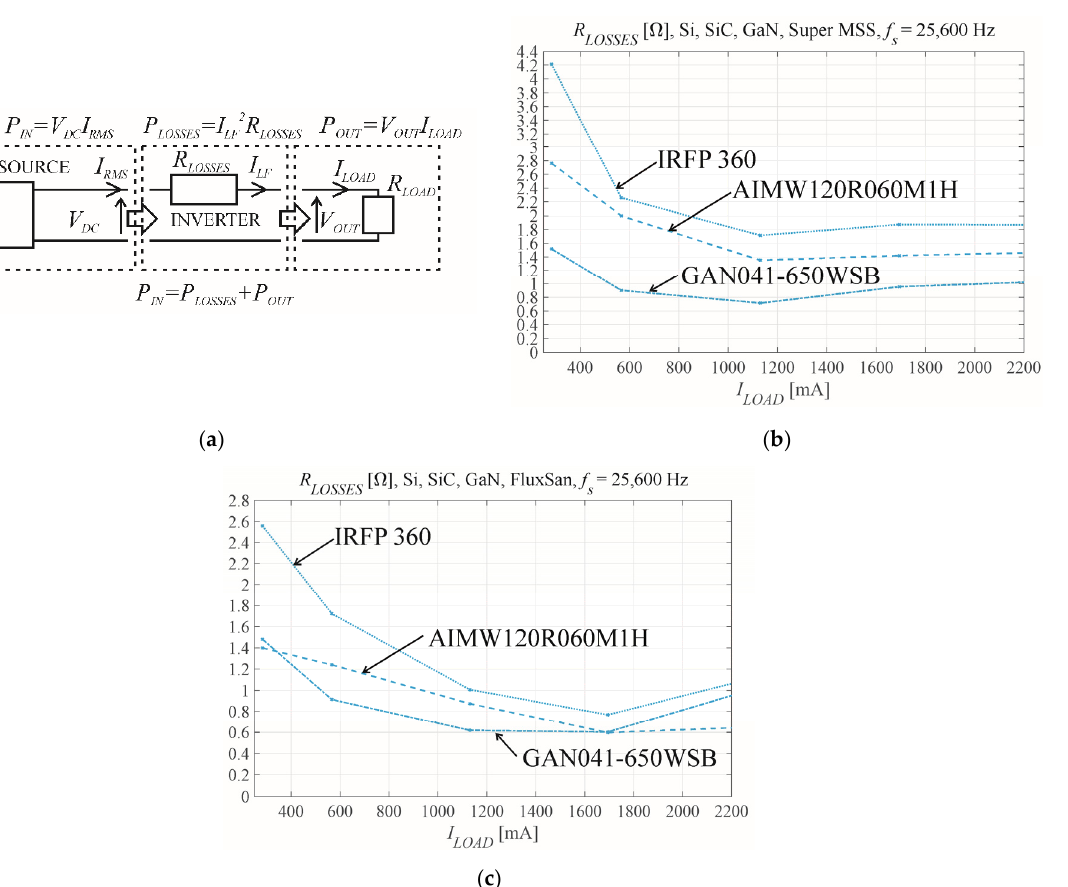
Figure 10. The power loss resistance R LOSSES measured from the power loss, showing ( a ) the method of measuring R LOSSES , and ( b ) exemplary values of R LOSSES for the Super MSS coil core at f s = 25,600 Hz, and ( c ) exemplary values of R LOSSES for the FluxSan coil core at f s = 25,600